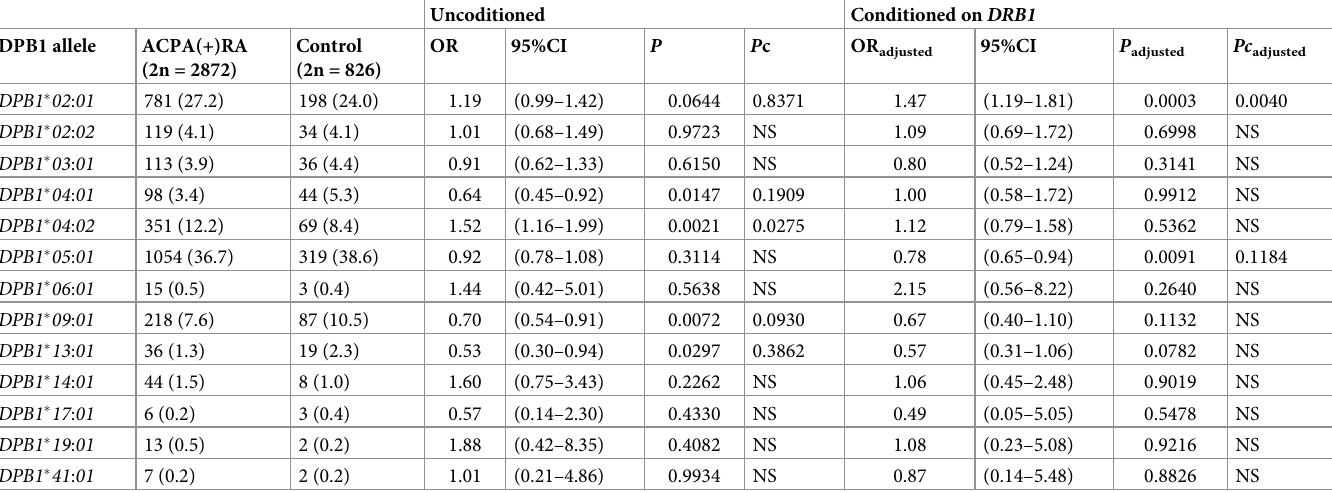
RA: rheumatoid arthritis, ACPA: anti-citrullinated peptide antibody, ACPA(+)RA: ACPA positive RA, OR: odds ratio, CI: confidence interval, P c: corrected P value, NS: not significant. Allele frequencies are shown in parenthesis (%).The association of each DPB1 allele with ACPA(+)RA was analyzed by logistic regression analysis. The left column indicates the results from unconditioned analyses. The right column indicates the results from analyses conditioned on DRB1 . P adjusted and OR adjusted were calculated by conditional logistic regression analysis under the additive model. Corrected P ( P c) values were calculated by multiplying the P value by the number of alleles